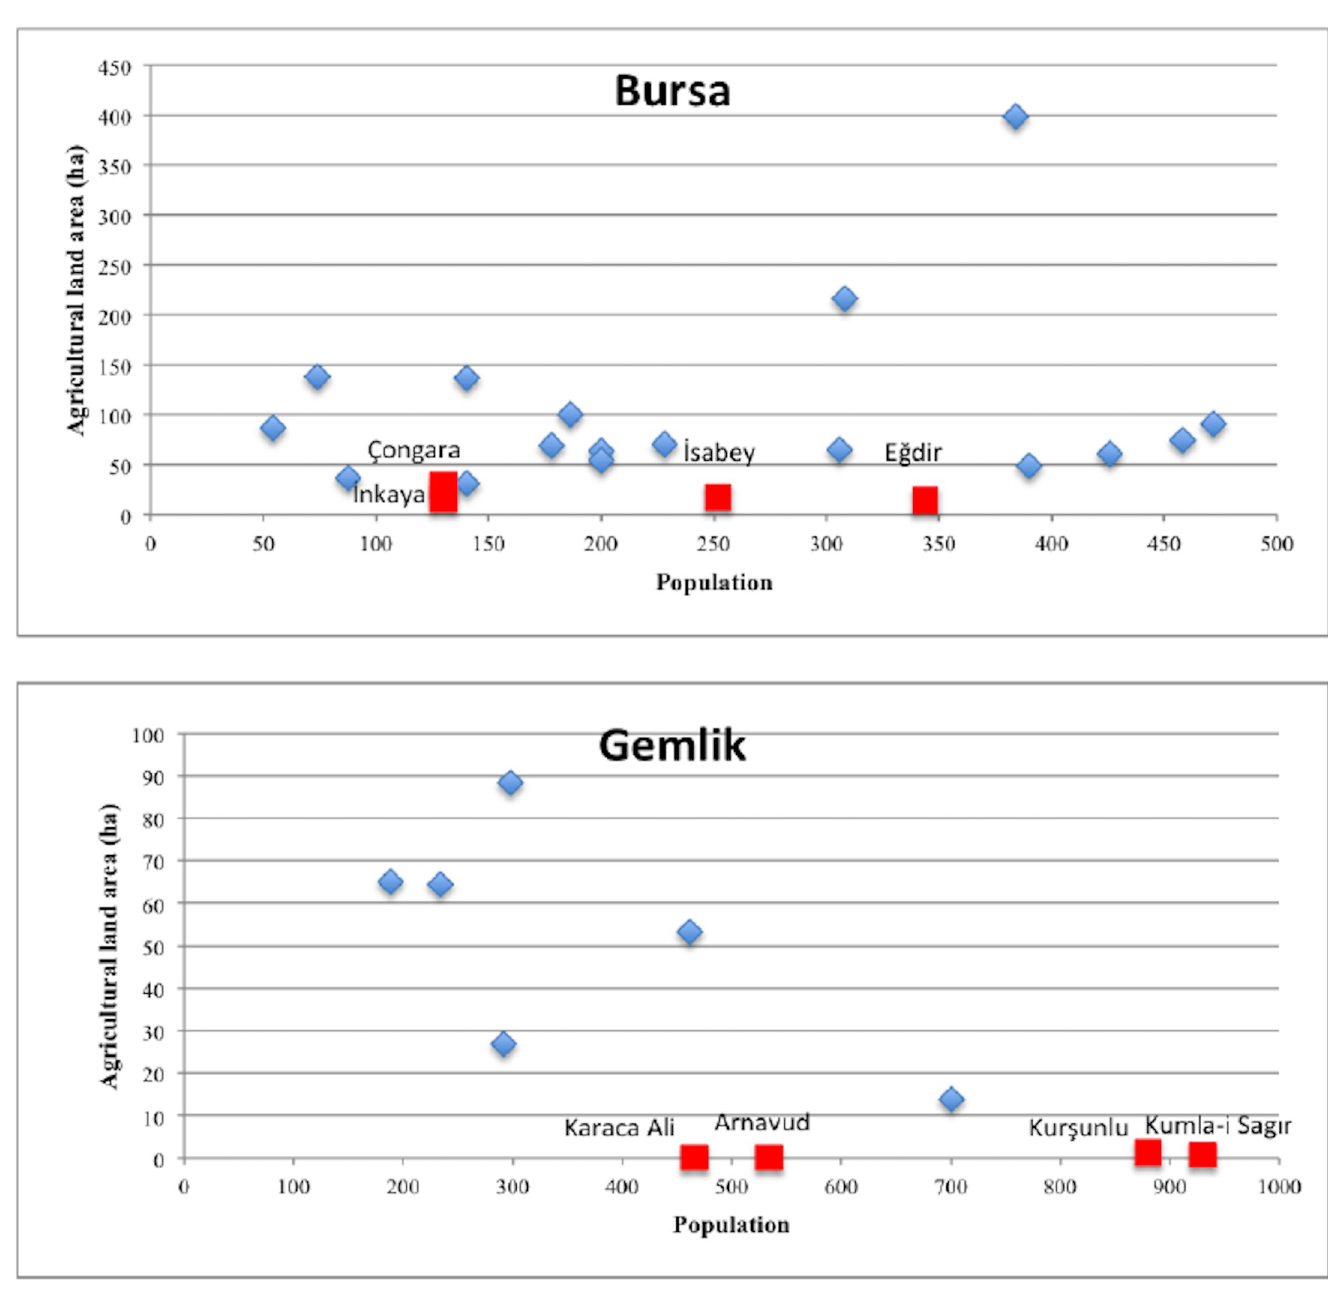
Fig 8. The observed relationship between population and agricultural land area in Bursa and